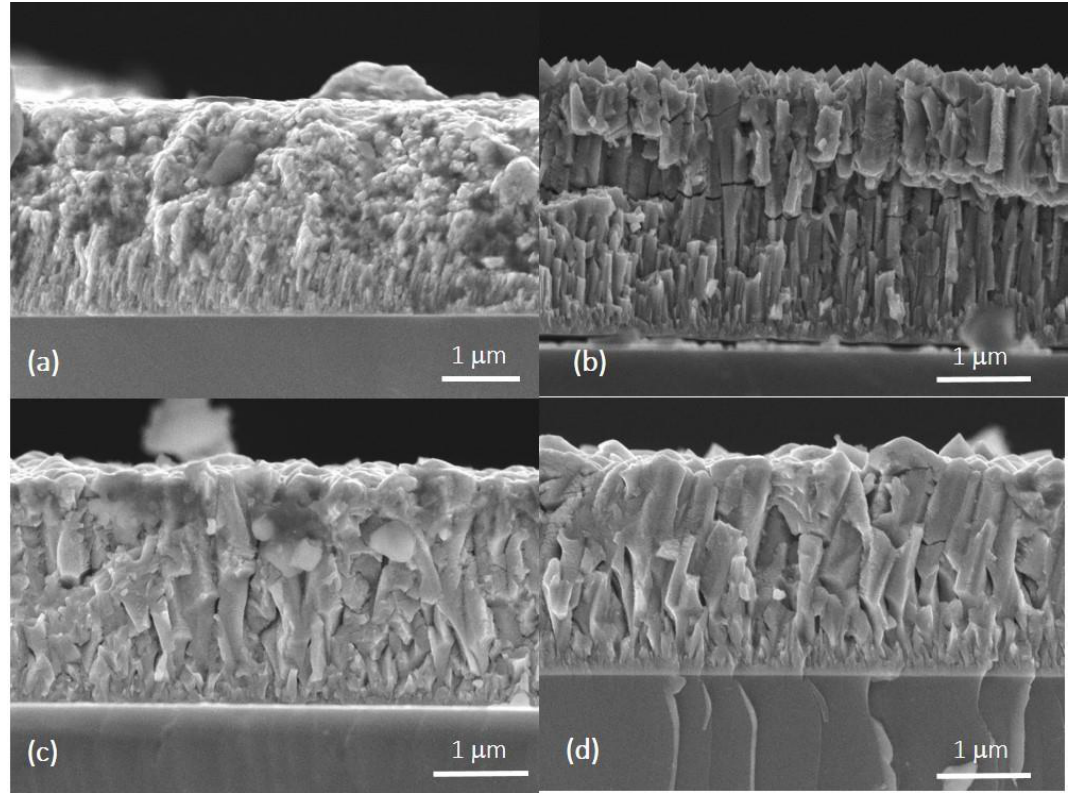
Figure 5. SEM cross-section images for films: ( a ) G1-25, ( b ) G1-150, ( c ) G1-250, and ( d ) G1-350. All images were taken in the secondary electron mode.